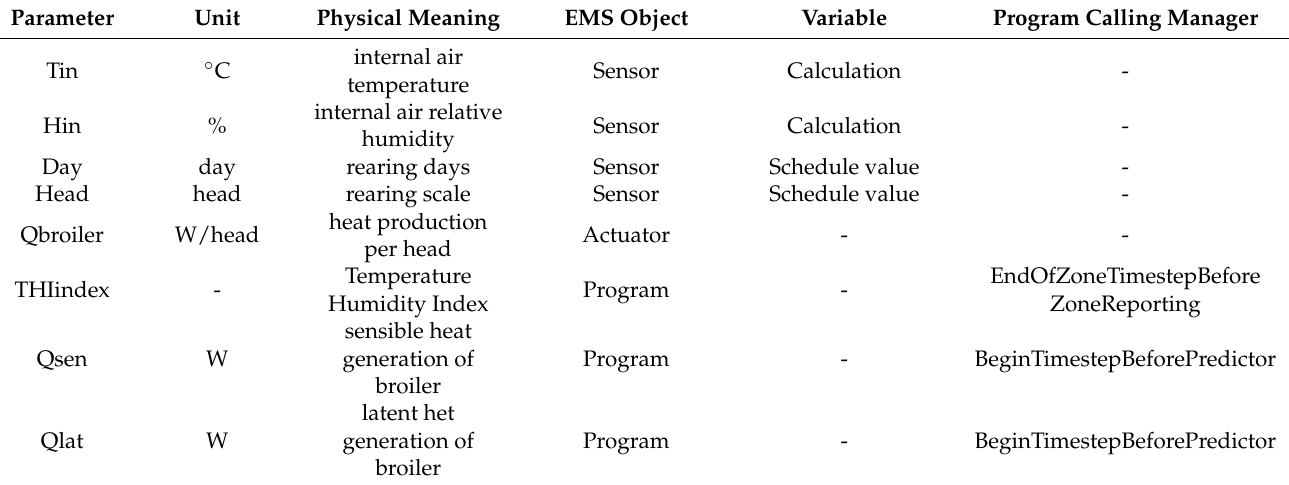
Table 2. EMS objects to consider to heat the production of